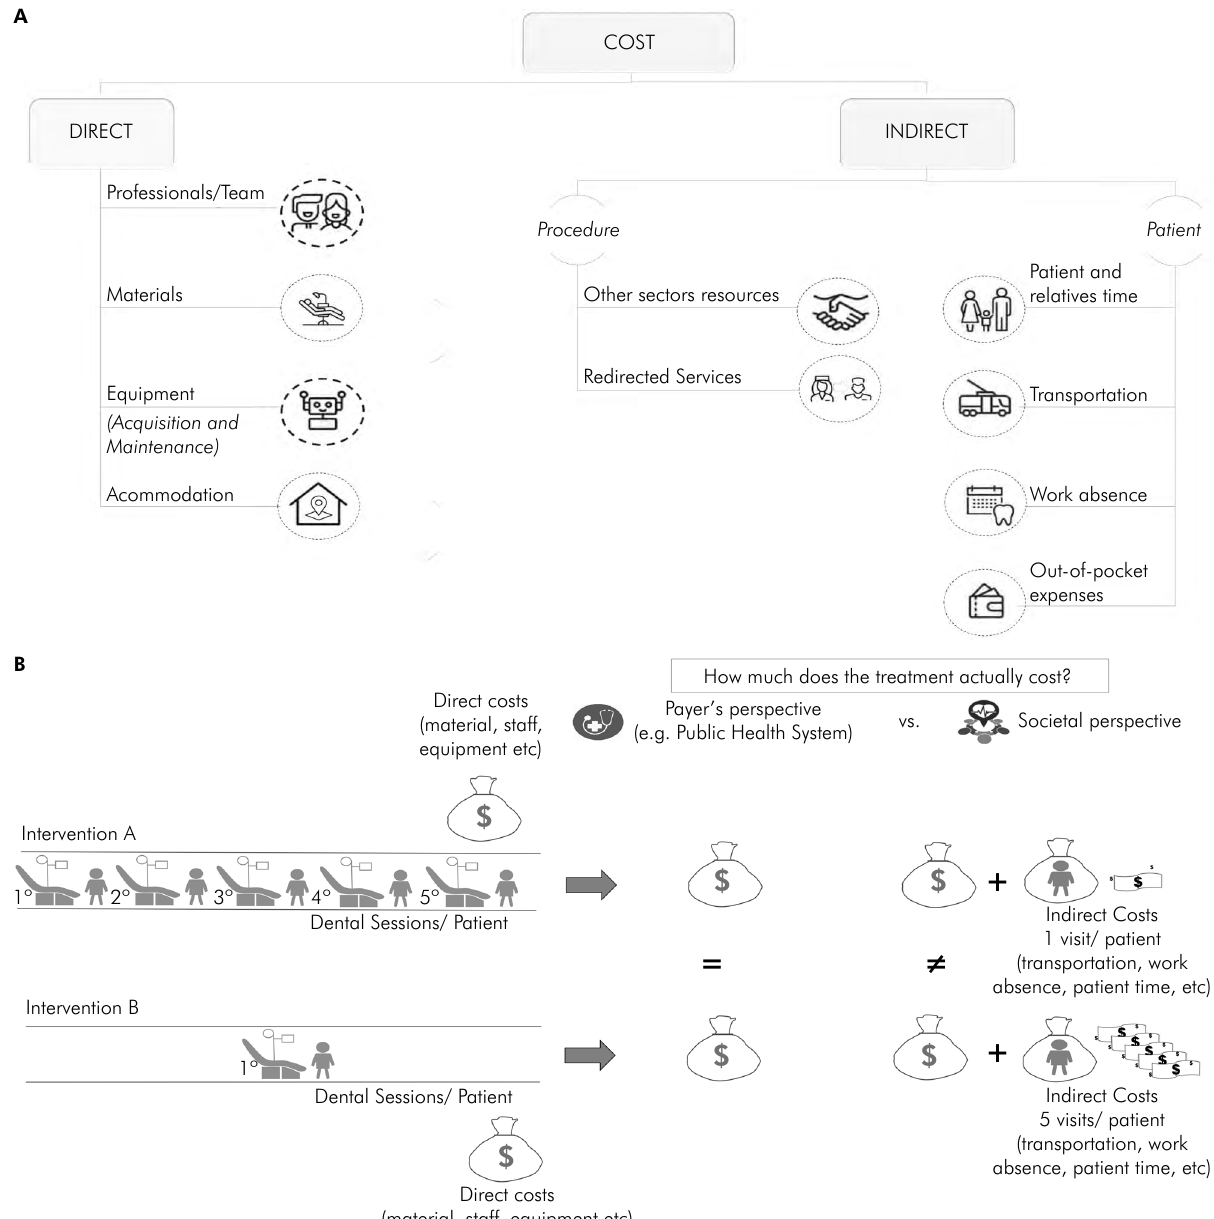
Figure 3. (a) Direct and Indirect costs related to the tested interventions. (b) Simulation of economic evaluation and costing (cost valuation) using different